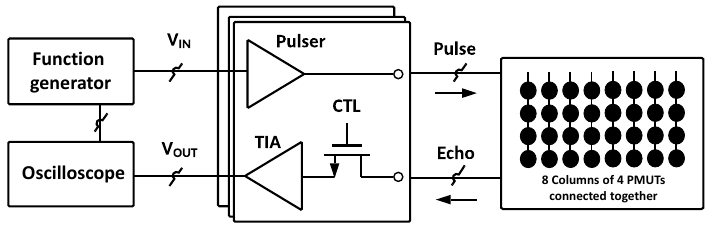
Figure 1. Block diagram of the proposed PMUT